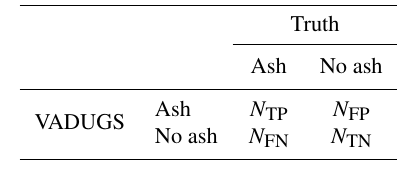
Table C1. Contingency table for the ash detection from VADUGS.